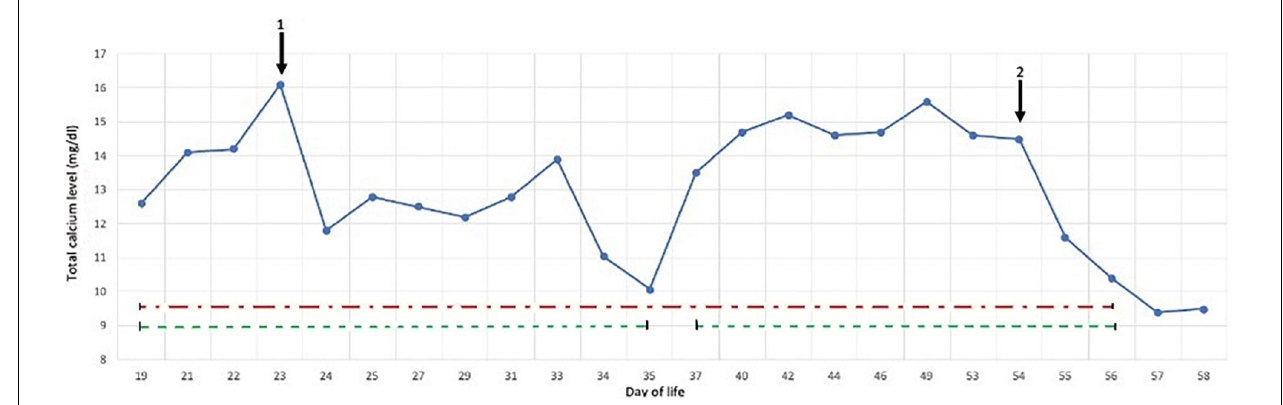
FIGURE 2 | Response of calcium levels to main treatments: hydrocortisone (1) suspendend at day 29, and pamidronate (2), diuretic therapy (dashed green line), hyperhydration (dash/dot red line).